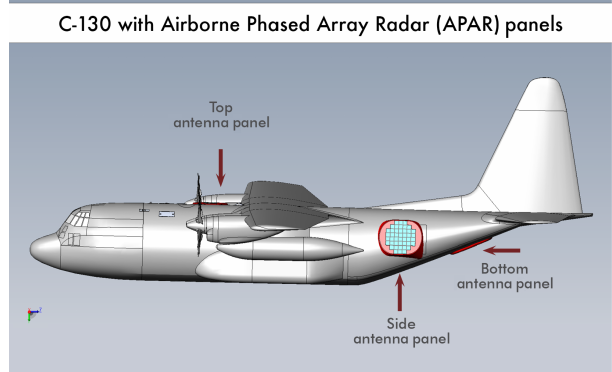
Figure 1. Notional schematic of APAR’s four AESA antenna panel placements on the C-130. There are two side panels on port and starboard of the fuselage, third panel on the top, and the fourth panel at the rear